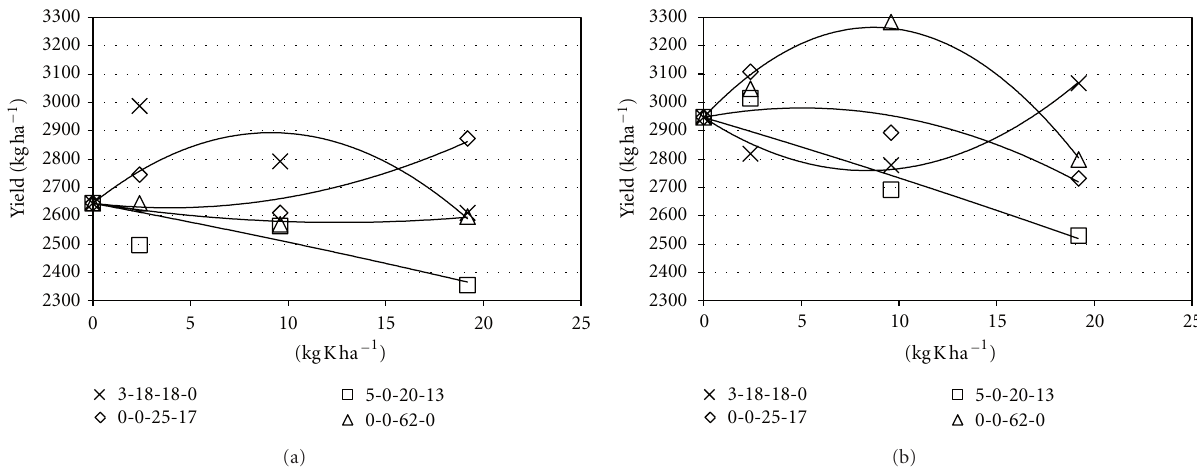
Figure 3: Soybean grain yield response to K-fertilizer additives (%N-%P 2 O 5 -%K 2 O-%S) of 3-18-18-0 ( y = − 29 . 108 x 2 + 54 . 656 x + 2644, R 2 = 0 . 29), 0-0-25-17 ( y = − 12 . 009 x 2 − 7 . 91 x + 2644, R 2 = 0 . 62), 5-0-20-13 ( y = 13 . 163 x 2 − 12 . 895 x + 2644, R 2 = 0 . 64), or 0-0-62-0 ( y = − 2 . 2418 x 2 − 10 . 684 x + 2644, R 2 = 0 . 84) applied alone to weed-free plots (a) and with glyphosate to weedy plots (b) for 3-18-18-0 ( y = 6 . 7384 x 2 − 44 . 786 x +2947, R 2 = 0 . 97), 0-0-25-17 ( y = − 16 . 937 x 2 +13 . 186 x +2947, R 2 = 0 . 6), 5-0-20-13 ( y = − 13 . 38 x 2 − 20 . 337 x +2947, R 2 = 0 . 89), and 0-0-62-0 ( y = 1 . 5132 x 2 + 72 . 982 x + 2947, R 2 = 0 . 98) at Portageville in 2004 and 2005. Data were combined over years, and comparisons between figures are valid. The nontreated, weed-free, and glyphosate plus nonionic surfactant plus diammonium sulfate grain yields were 1160, 2640, and 2120 kgha − 1 , respectively. The LSD ( P ≤ 0 . 01) was 670 kg ha − 1 .